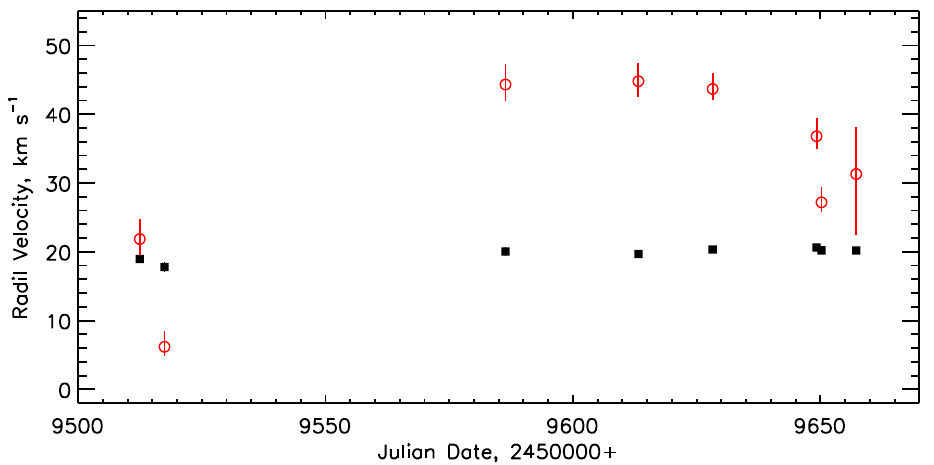
Figure 4. Radial velocity curve for HD36030. Red dots display average values for radial velocity for different lines listed in Table 2 for a given night. Error bars represent the spread of individ- ual line velocities. For comparison, black dots show the average velocity of the NaI λ 5890,5896 interstellar